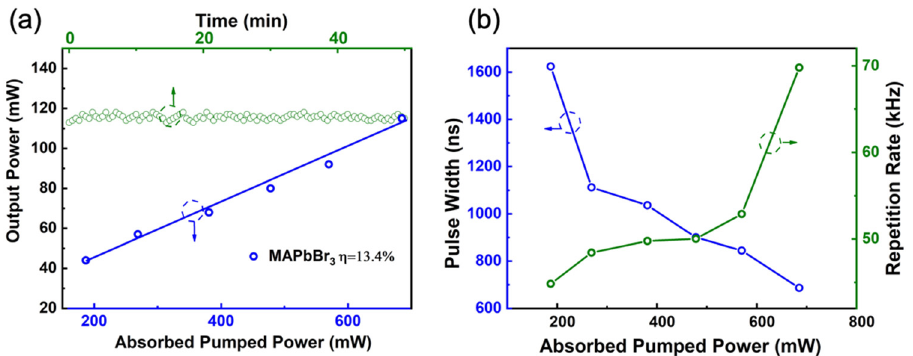
Figure 10. The performance of Q-switched laser operation including ( a ) average output power and instability variation with time; ( b ) pulse width and repetition rate as a function of absorbed pumped power.